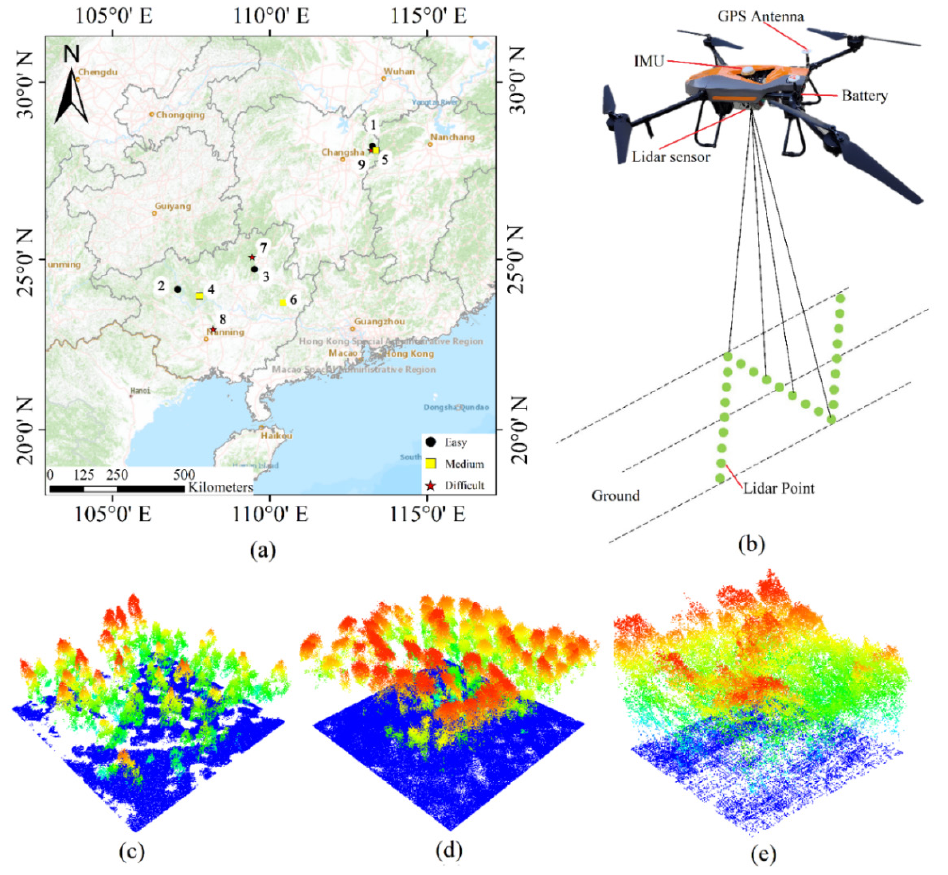
Figure 1. ( a ) The location of the study area; ( b ) UAV-LiDAR system; ( c – e ) plots with three types of UAV-LiDAR point clouds: easy, medium, and difficult.